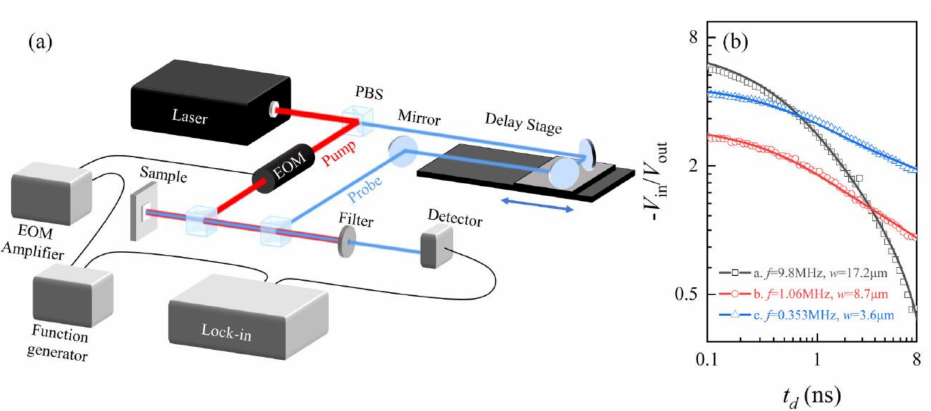
Figure 4. ( a ) Schematic of a typical TDTR setup. ( b ) The ratio between in-phase and out-of-phase signals, − V in / V out as a function of delay time is compared with the thermal modeling to extract the thermal conductivity. Reprinted with permission from Ref. [39]. Copyright 2021, AIP